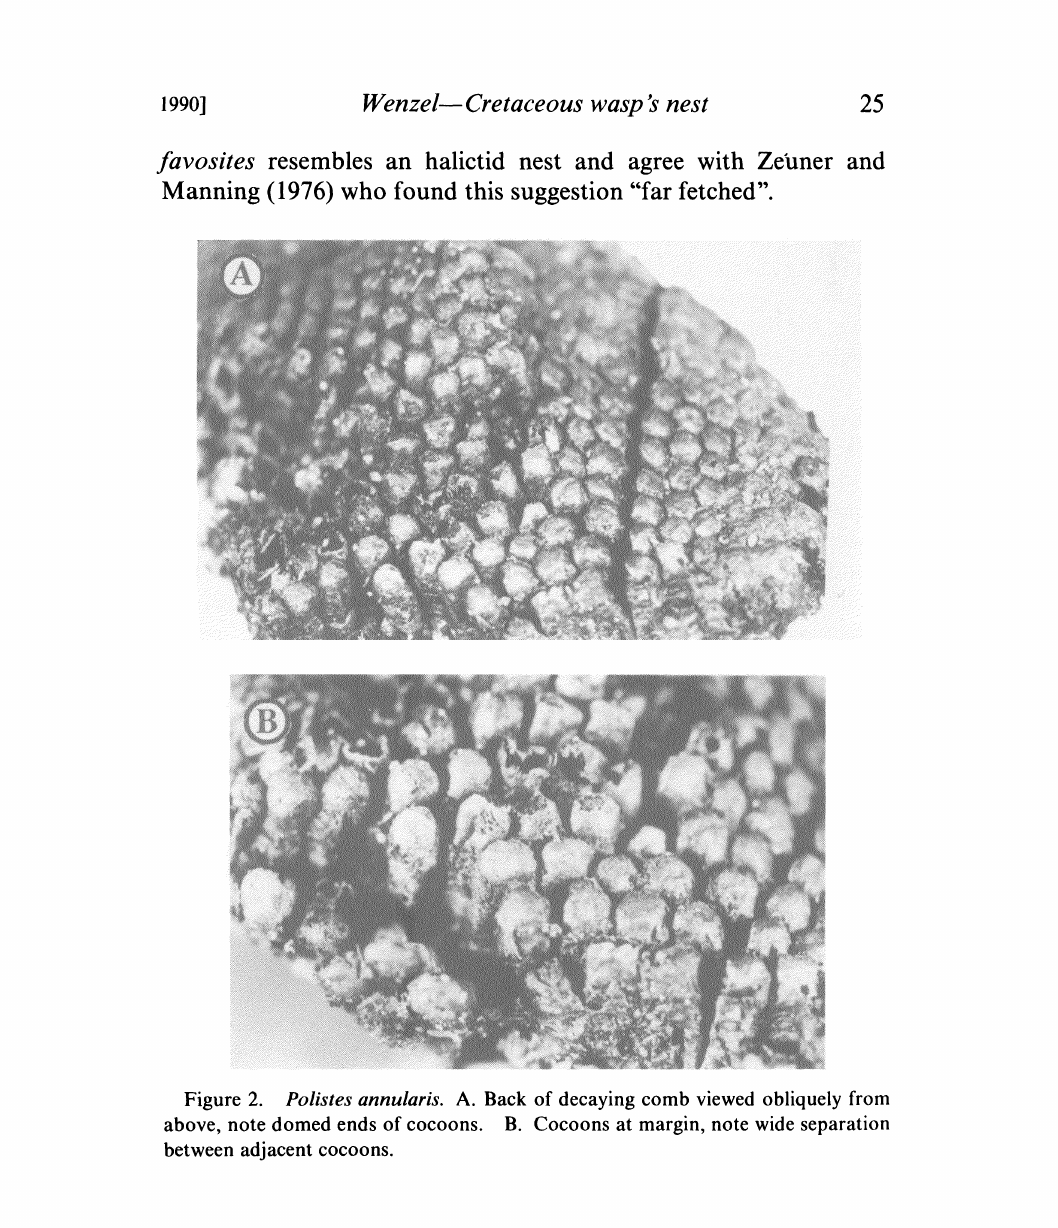
Figure 2. Polistes annularis. A. Back of decaying comb viewed obliquely from above, note domed ends of cocoons. B. Cocoons at margin, note wide separation between adjacent